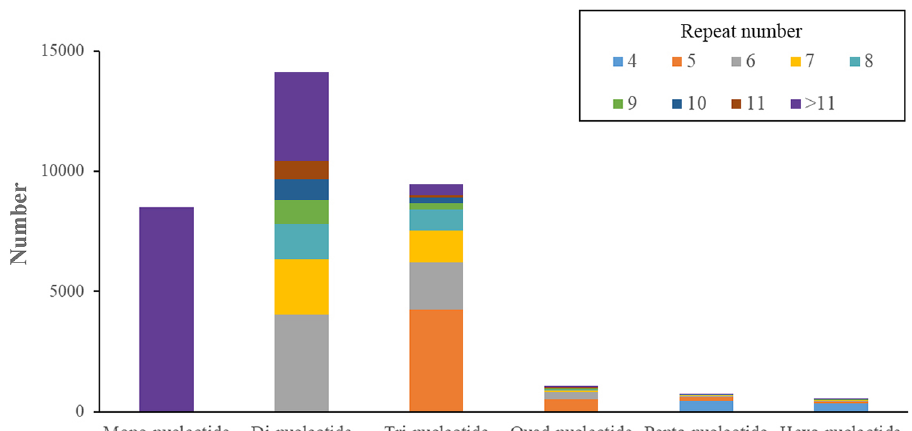
Figure 5. The distribution of different